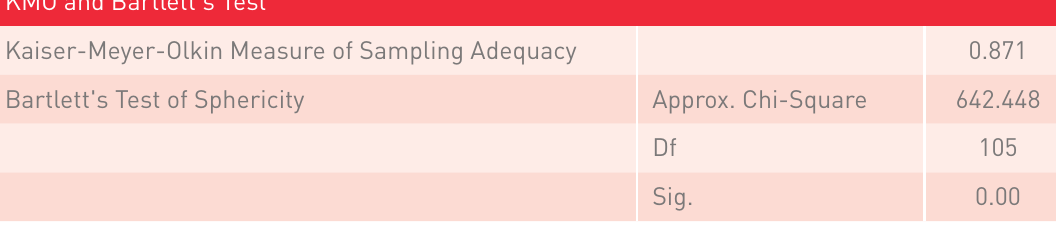
KMO and Bartlett's Test for Awareness of 3D Printing